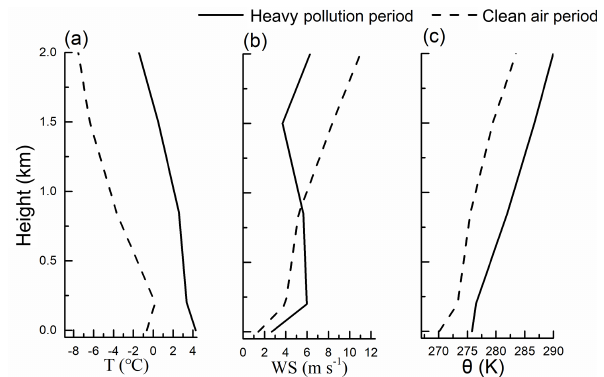
Figure 6. Vertical profiles of (a) air temperature, (b) wind velocity, and (c) potential temperature averaged in the heavy pollution peri- ods P1, P2, and P3 and in the clean-air period over Wuhan during January 2016.